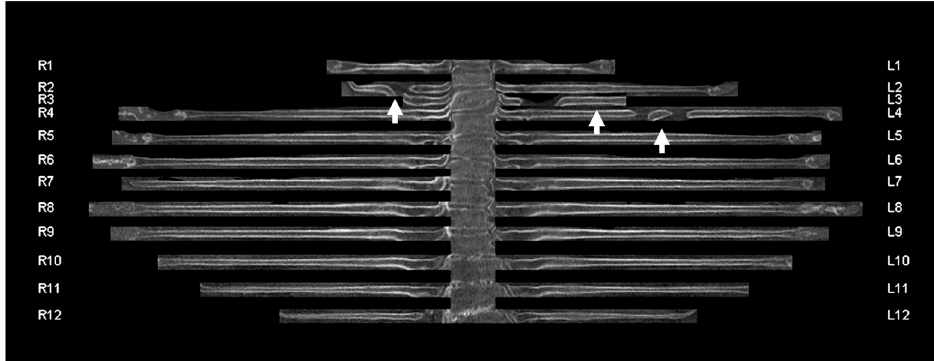
Figure 2. Unfolded rib view of an 83-year-old female patient with reconstruction errors. The centerlines of three ribs were not correctly detected by the algorithm (white arrows). R1-12 refers to the 1st to 12th rib of the right hemithorax. L1-12 refers to the 1st to 12th rib of the left hemithorax.